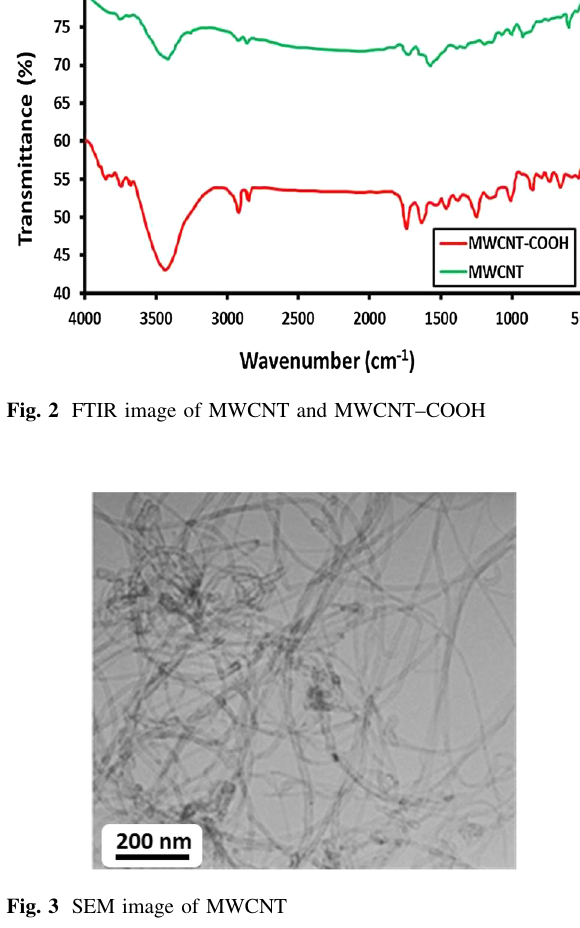
Fig. 3 SEM image of MWCNT